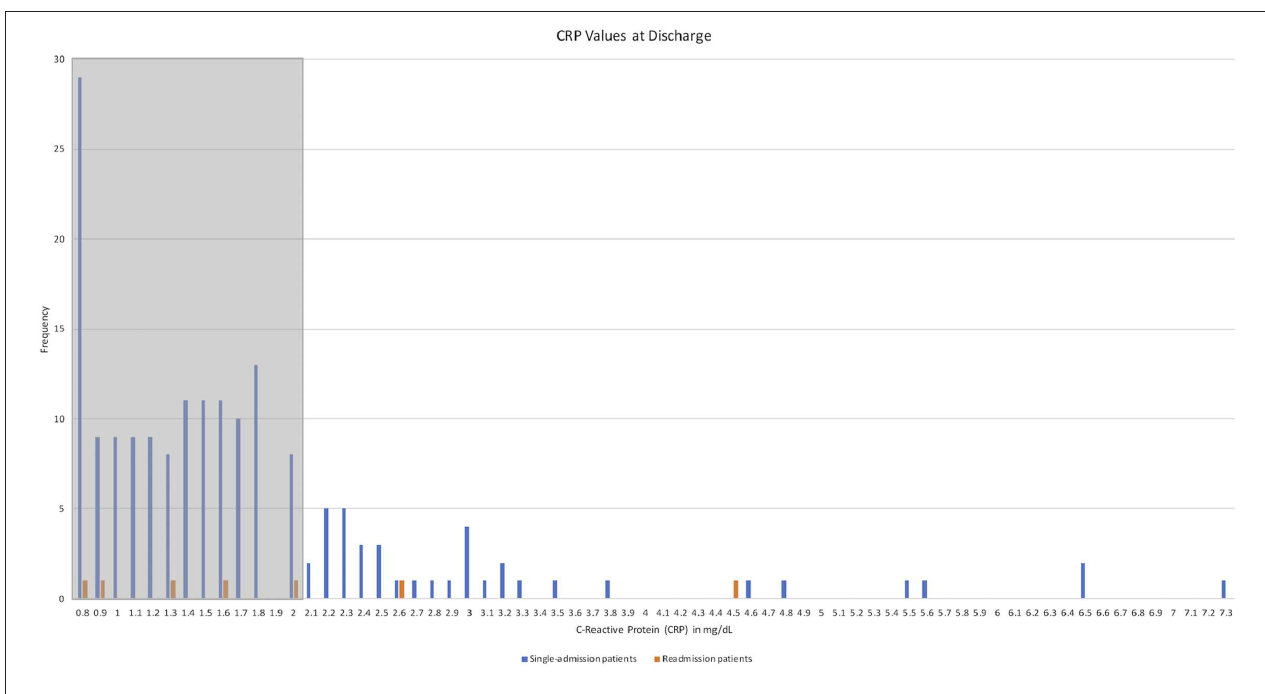
FIGURE 1 | CRP values at